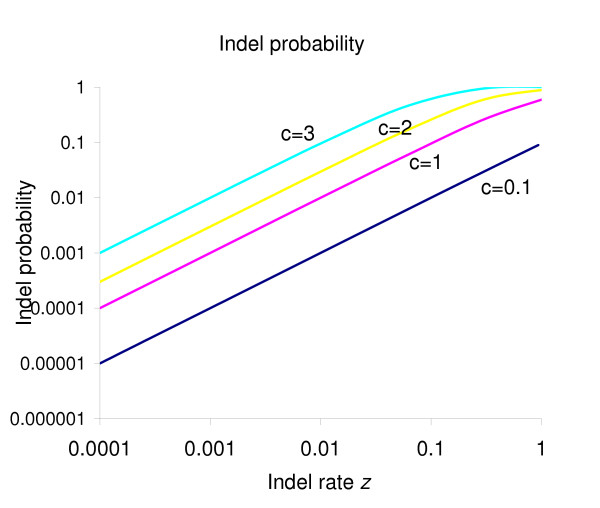
The indel probability of the GCG distribution is determined by the indel rate z (x-axis) and the evolutionary scale factor c (labelled next to the corresponding line). This probability can be set by the user to influence the number of indels present in the final alignment.